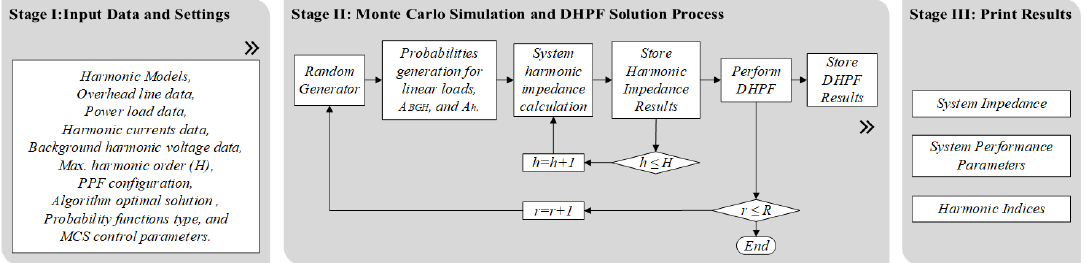
Figure 8. Generalized process of the proposed MCS-based method.